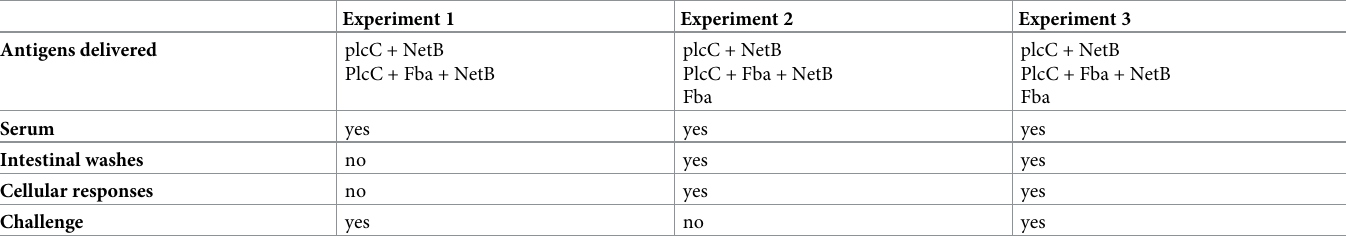
Table 2. Outline of experiments 1, 2 and